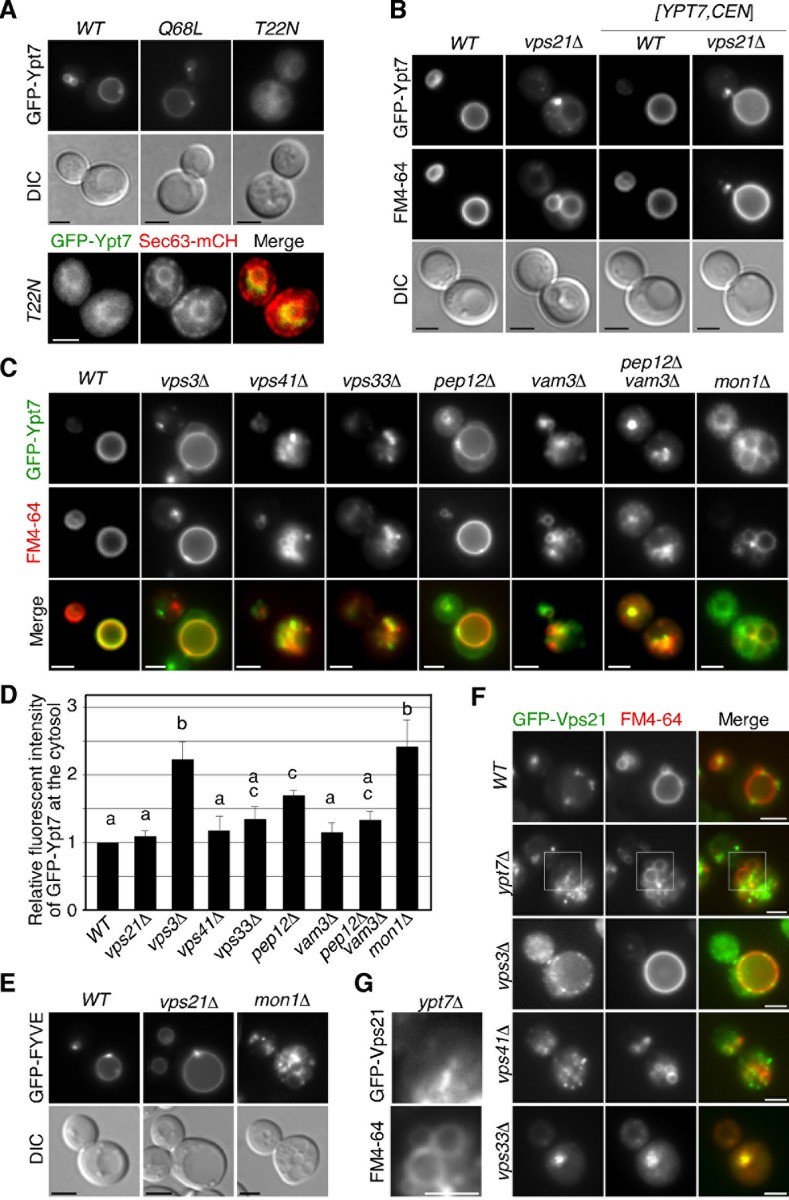
Localization of yeast Rab7 in wild-type and mutant cells.(A) Localization of putative GTP- or GDP-locked mutant of Ypy7p in living cells. Cells were grown to early to mid-logarithmic phase in YPD medium at 25°C and observed by fluorescence microscopy and DIC (upper panels). Colocalization of GFP-Ypt7(T22N) with mCherry-fused Sec63p (lower paneles). Each image pair was acquired at successive 2 sec (s) intervals. (B) Localization of GFP-Ypt7p in wild-type or vps21Δ cells. Cells were labeled with 200 μM FM4-64. Cells expressing Ypt7p from a single copy plasmid were grown to mid-logarithmic phase in selective synthetic rich medium at 25°C. (C) Localization of GFP-Ypt7p in wild-type and mutant cells. All cells express Ypt7p from a single copy plasmid. Cells were labeled with FM4-64 and observed as described above. (D) The graph shows quantification of the fluorescence intensity of GFP-Ypt7p in the cytosol. Error bars represent the SEM from at least three experiments (n > 50 cells for each strain per experiment). Different letters indicate significant difference at p < 0.05 (S2 Table) (One-way ANOVA with Tukey’s post-hoc test). (E) Localization of GFP-fused FYVE domain (EEA1) in wild-type and mutant cells. (F) Localization of GFP-Vps21p in wild-type and mutant cells. Cells were labeled with FM4-64. (G) Higher magnification views of the boxed areas in (F). Scale bars, 2.5 μm.